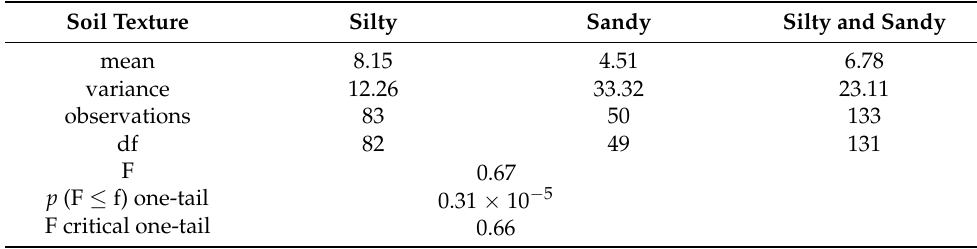
Table 2. CW-SOC’s F-test two-sample for